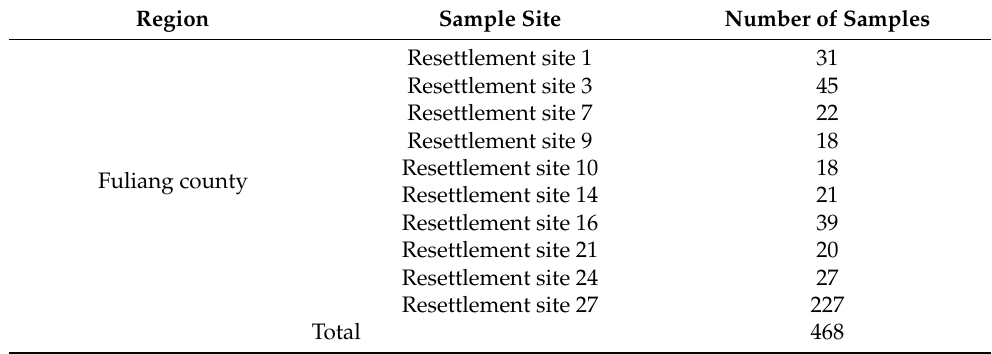
Table 2. Sample location distribution.